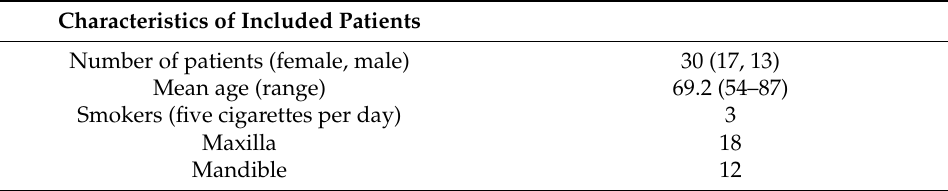
Table 1. Main characteristics of included patients (mean age in years). Characteristics of Included Patients Number of patients (female,